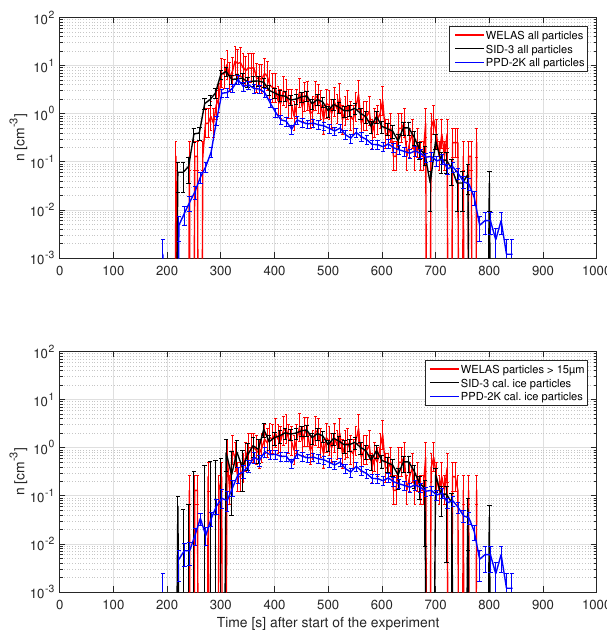
Figure 11. Comparison of number concentrations measured dur- ing AIDA RICE 03 expansion run 27. Upper panel: total number concentrations of the WELAS, the SID-3 and the PPD-2K. Lower panel: respective ice particle number